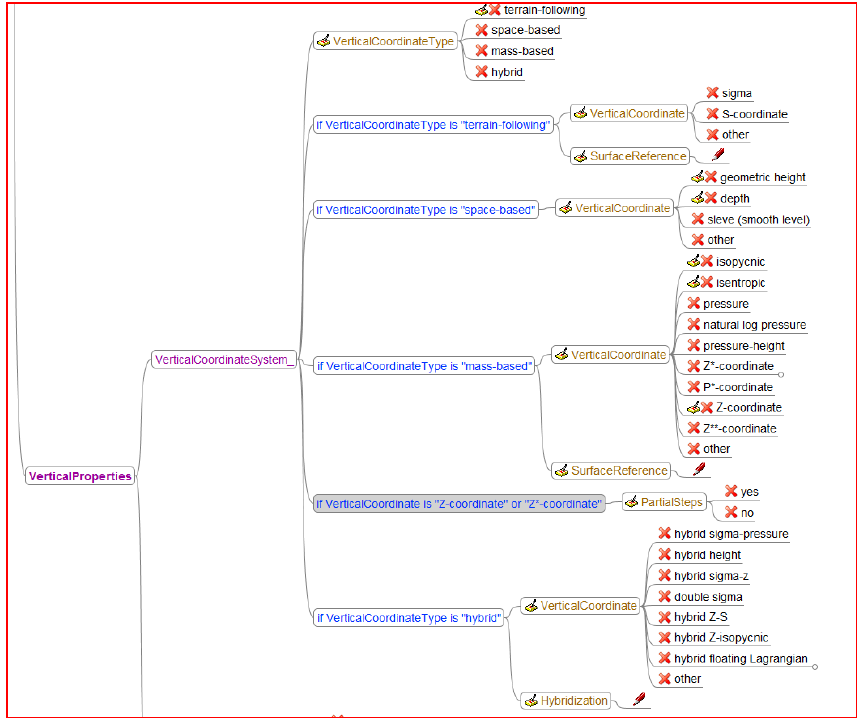
Fig. 3. A portion of the model grid CV. Same typographic rules as in Fig. 2 are applied. The parameter group VerticalCoordinateSystem gathers information about the vertical coordinate system used by the